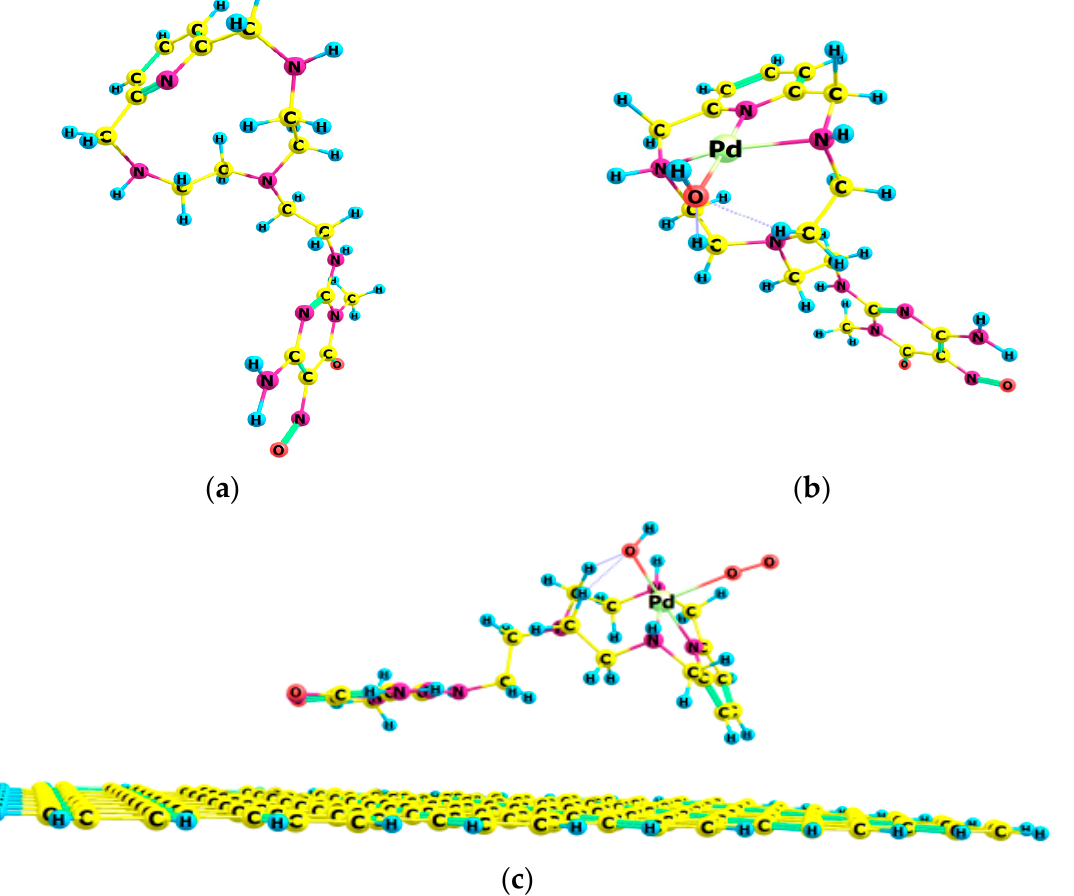
Figure 1. Molecular structures for the ORR catalyst: ( a ) HL1 ( b ); HL1-Pd(II)-OH − complex; ( c ) Cat1 final adduct C2D-HL1-Pd(II)-OH − with O 2 interaction.